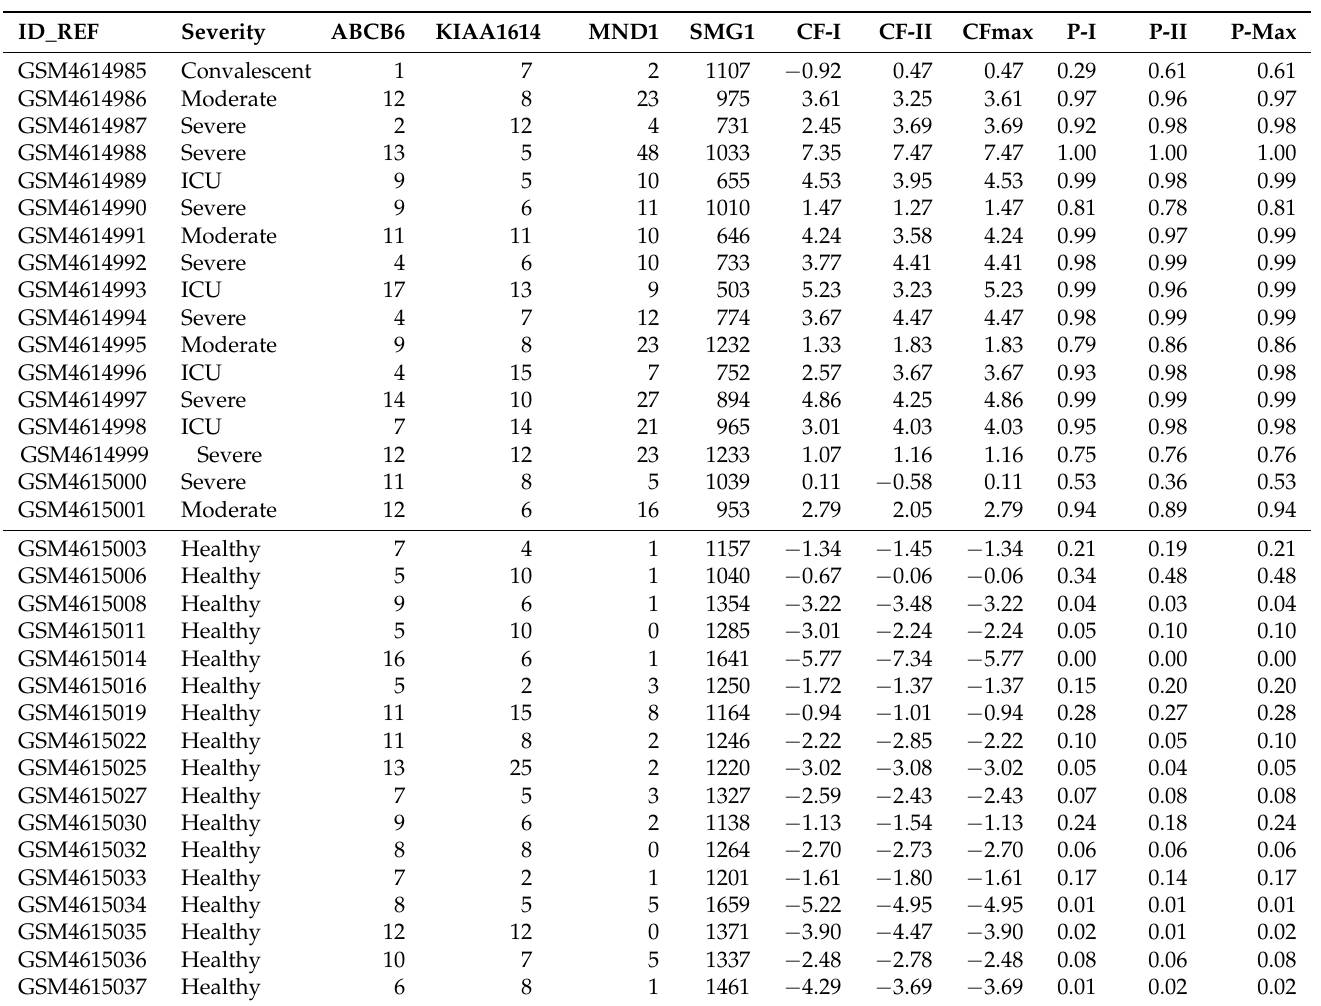
Table 7. The third data: Expression values of four critical genes, their classifier values, risk